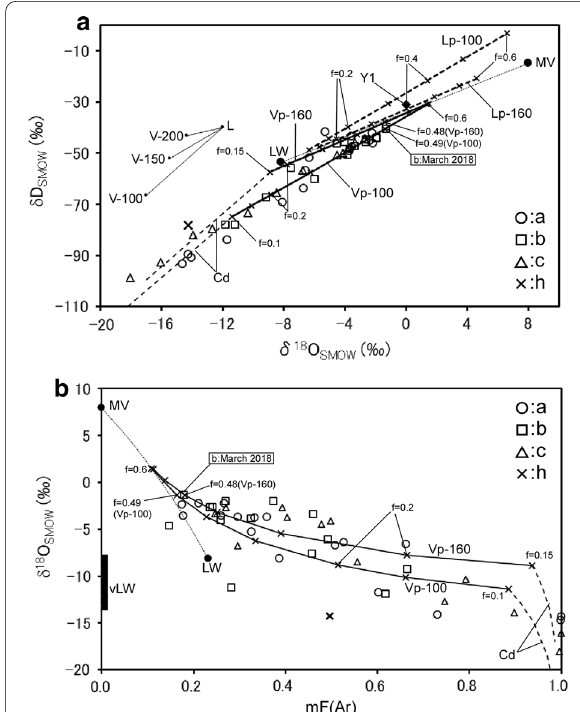
Fig. 9 a δD and δ 18 O of H 2 O in fumarolic gas with the calculated vapor phase ( V p) and liquid phase ( L p). Vp-100 and V p-160 denote V p of 100 °C and 160 °C, respectively. L p-100 and L p-160 denote L p at the temperature of 100 °C and 160 °C, respectively. The broken lines annotated as Cd indicate the isotopic ratio of remaining water vapor after partial condensation. V-100, 150 and 200 are the isotopic ratios of water vapor equilibrated with liquid L at 100 °C, 150 °C, and 200 °C, respectively. b Magnified Ar fraction, mF(Ar), and δ 18 O of H 2 O in fumarolic gases with V p-100 and V p-160. vLW indicates the vapor phase generated from local meteoric water